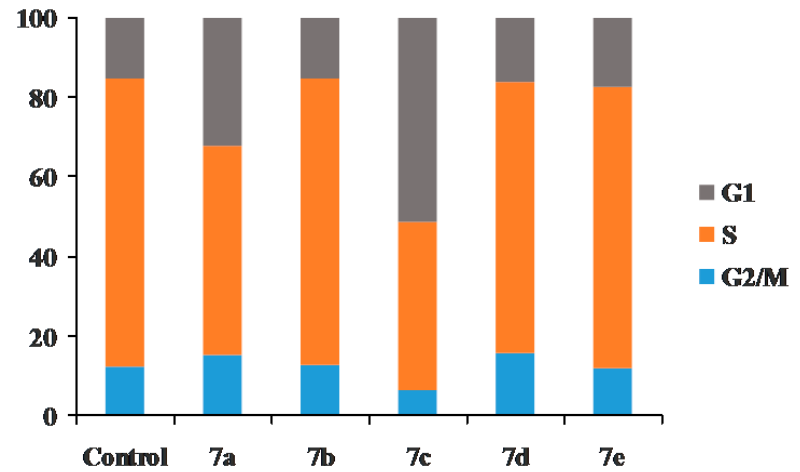
Figure 4. Cell cycle analysis by flow cytometry of H22 cells treated with 7a – 7e for 48 h: (1) control; (2) 7a , 3 µ M; (3) 7b , 3 µ M; (4) 7c , 3 µ M; (5) 7d , 3 µ M; and (6) 7e , 3 µ